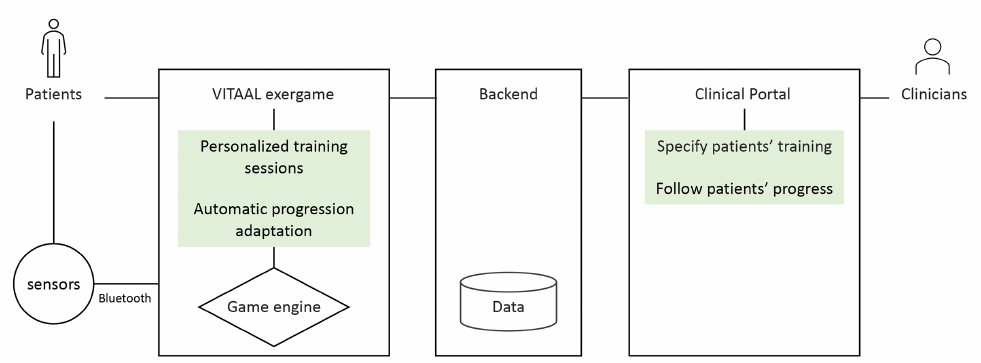
Figure 6. System